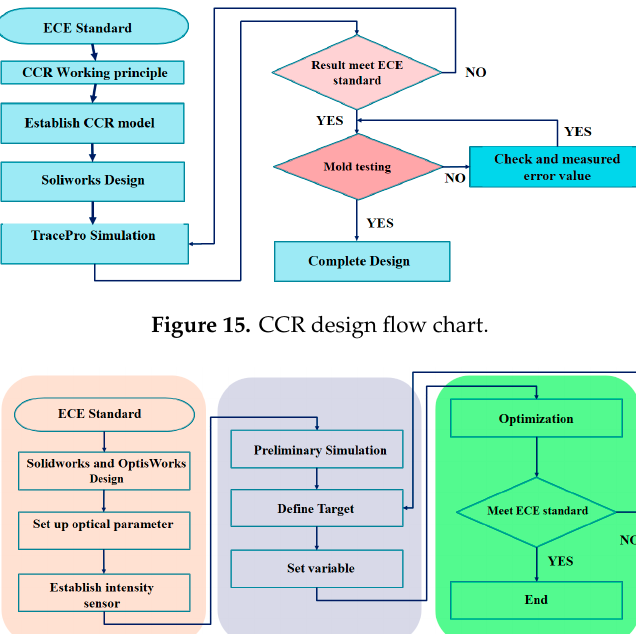
Figure 14. The recorded value for the intensity sensor versus running cycles.